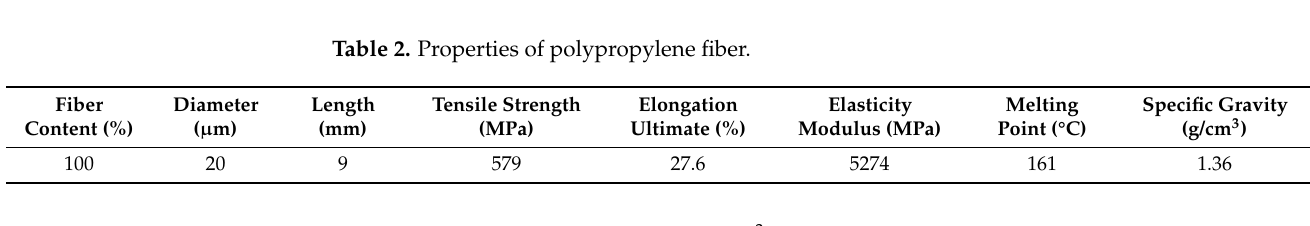
Table 3. Mix proportion of concrete (kg/m 3